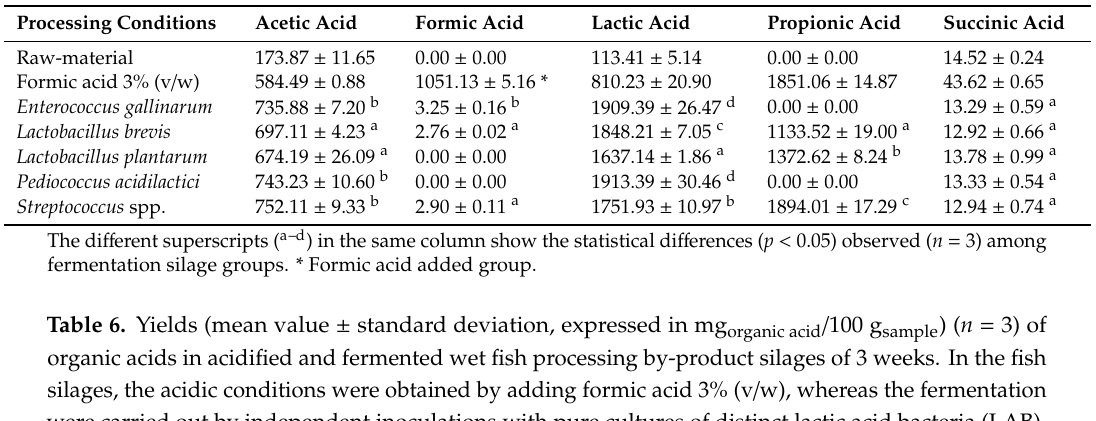
Table 5. Yields (mean value ± standard deviation, expressed in mg organic acid / 100 g sample ) ( n = 3) of organic acids in acidified and fermented wet klunzinger’s ponyfish ( Equulites klunzingeri ) silages of 3 weeks. In the fish silages, the acidic conditions were obtained by adding formic acid 3% (v / w), whereas the fermentation were carried out by independent inoculations with pure cultures of distinct lactic acid bacteria (LAB).